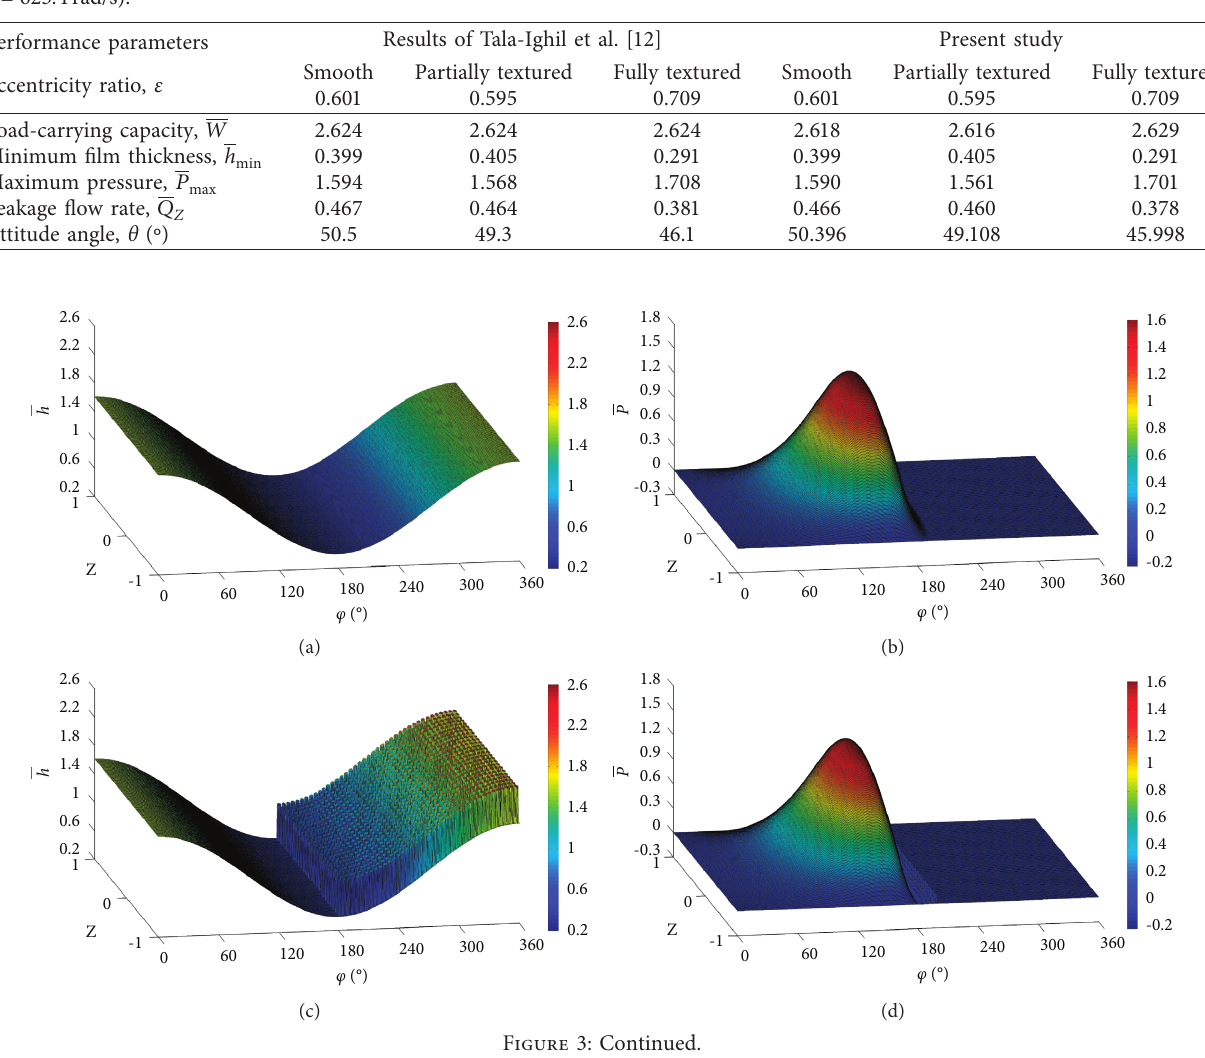
Table 2: Model validation of static performance characteristics of smooth/textured journal bearing ( L / D , c � 30 μ m, u � 0 . 0035Pa · s, and ϖ � 625 . 4